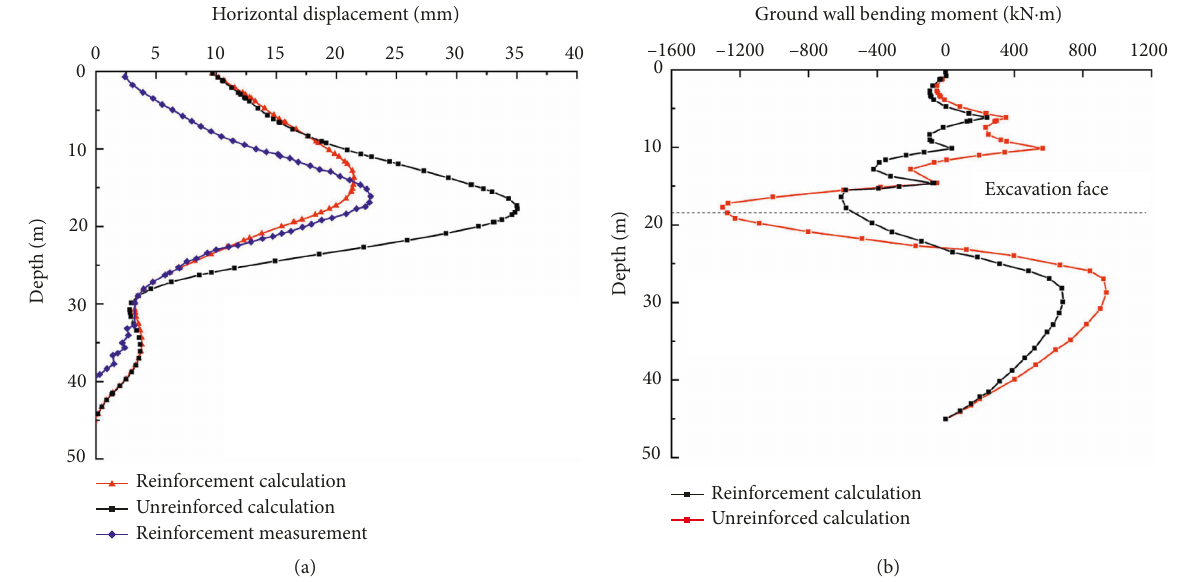
Figure 4: Horizontal displacement and bending-moment diagram of the diaphragm wall. (a) Horizontal displacement of the diaphragm wall. (b) Bending-moment diagram for the diaphragm